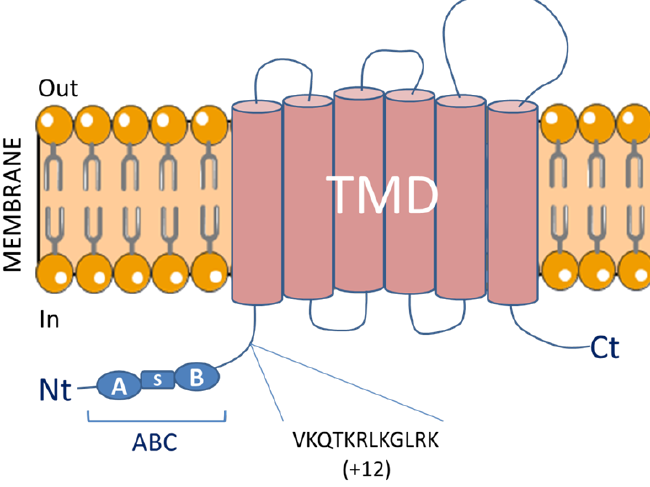
Figure 1. Structure of the membrane ATP-binding cassette G1 (ABCG1) transporter. ABCG1 is a member of the ABC superfamily of transporters and contains one ABC domain containing three highly conserved domains (Walker A (A), Walker B (B) and Signature motif (S)) and one transmembrane domain (TMD) consisting of six membrane-spanning α-helices. The 12 amino acids present in the long ABCG1 isoform (+12AA) are indicated. Functional ABC transporters require two ABCs and two TMDs, therefore, the ABCG1 half-transporter must homodimerize or heterodimerize with others ABC partners in order to be functional. Nt: N-terminus; Ct: C-terminus.